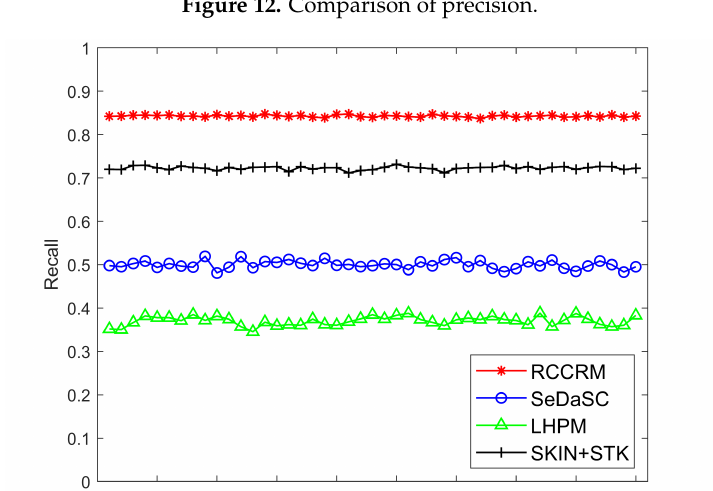
Figure 12. Comparison of precision.